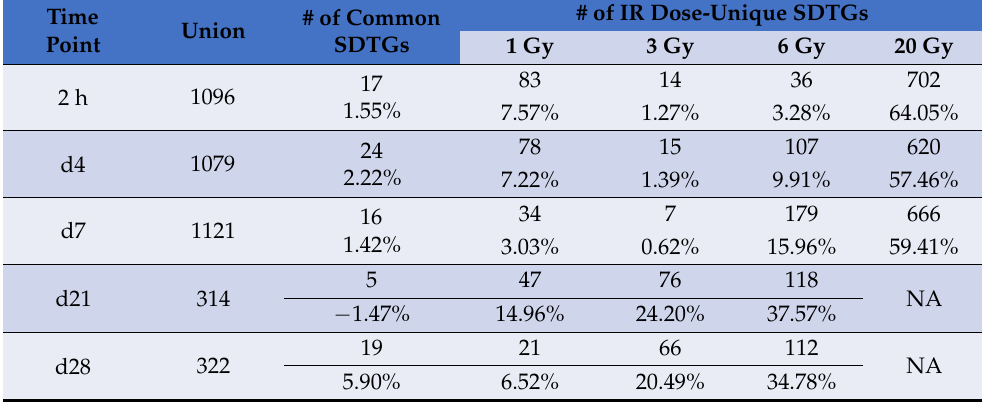
Table 4. Time point-based comparison of SDTGs’ ( p < 0.05 and FC ≥ 2) distribution among responses to all IR doses.